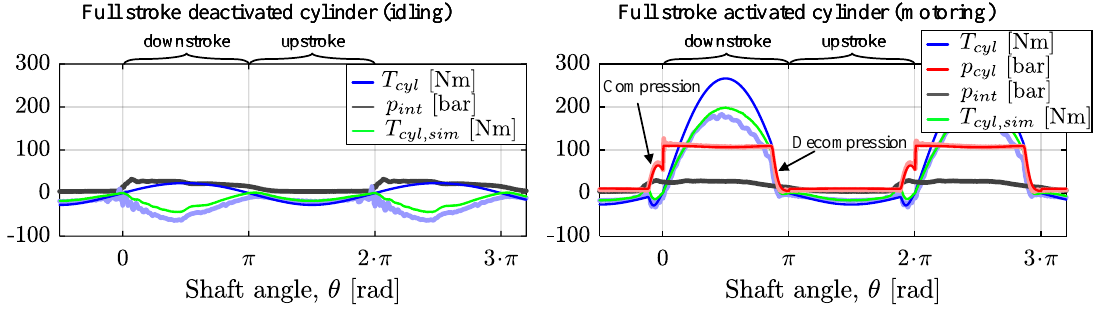
Figure 14. Experimental and simulated results for full stroke motor operation when leakage was introduced in the simulation model (light color is experimental results, and dark color is simulation